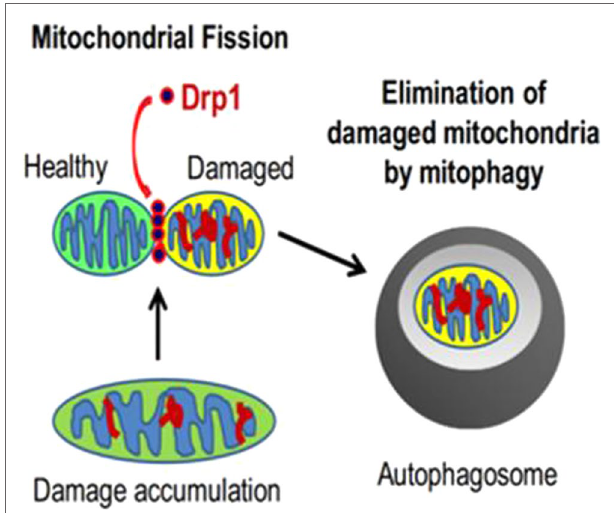
FIGURE 1 | The relationship between mitochondrial fission and mitophagy (Ikeda et al., 2015).